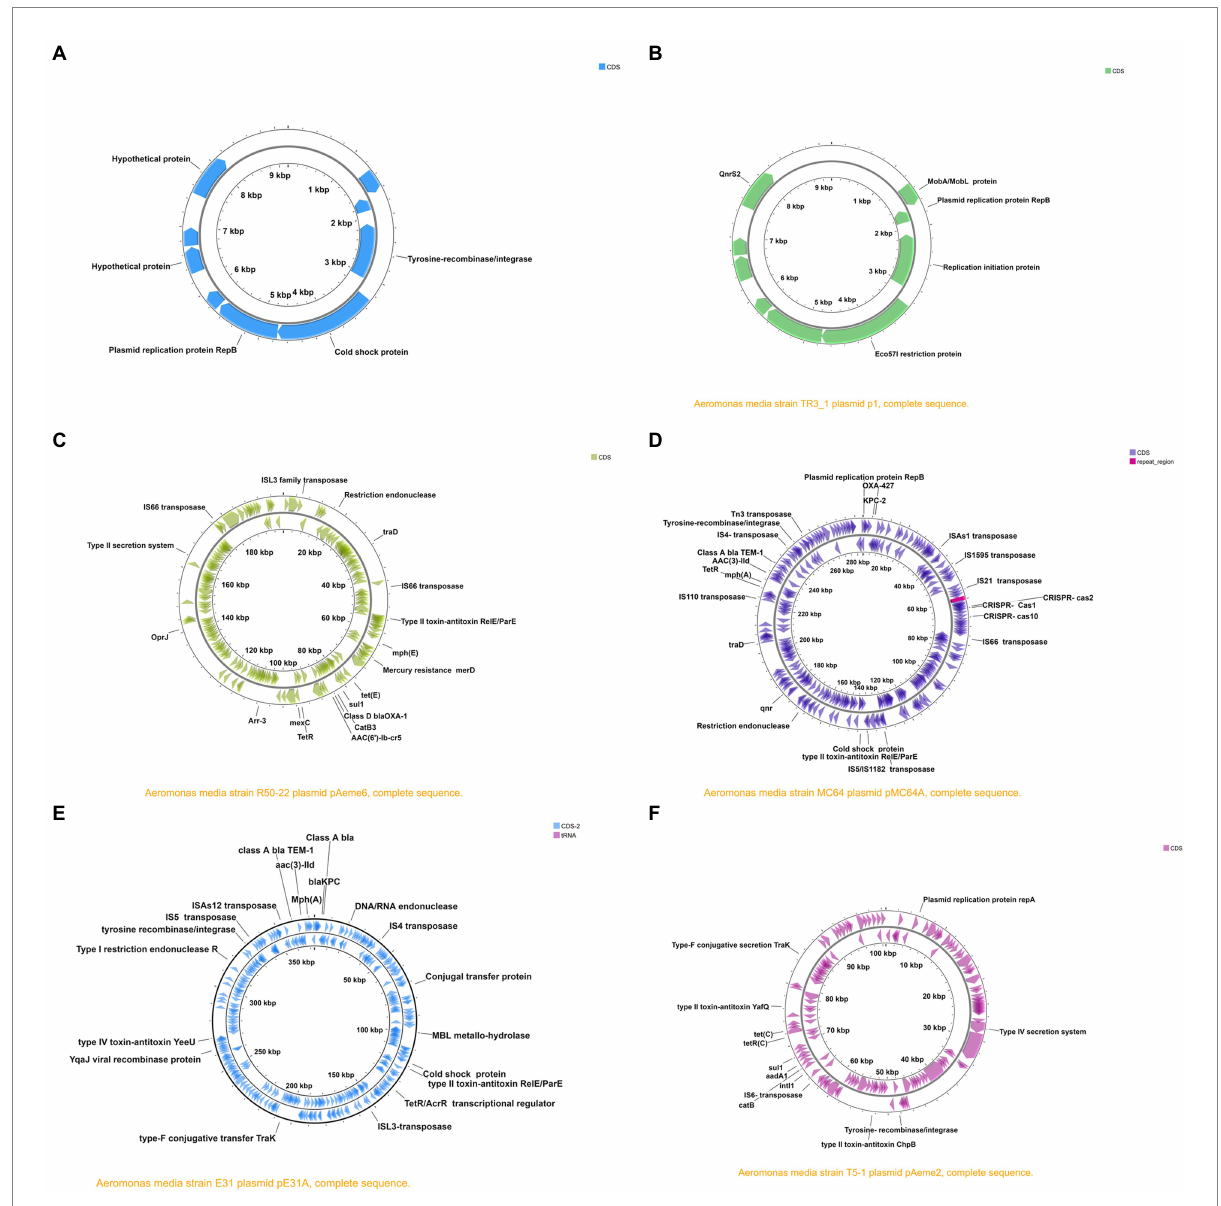
FIGURE 4 Circular maps of plasmids (i) pSD/21–15 isolated from Denmark (A) , (ii) pTR3_1 waste water treatment from United States (B) , (iii) pR50_22 from a sludge in China (C) , (iv) pMC64 from a hospital in China (D) , (v) pE31 from water in China (E) , and (vi) pT5-1 from a sludge in China (F) . Note that the location of virulence factors, antimicrobial resistance (AMR) genes, transposases, efflux pumps, secretion system, and other genes are shown in the circular map for each the